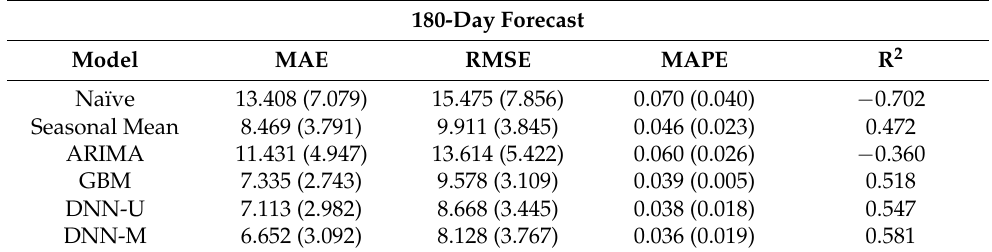
Table 8. Estimates for MAE, RMSE, MAPE, and R 2 calculated using TSCV for a 180-day forecast.